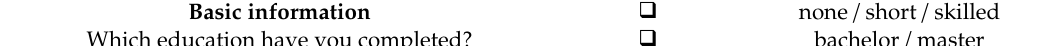
Table 4. Practical application of the breastfeeding score. The written postpartum questionnaire for mothers.